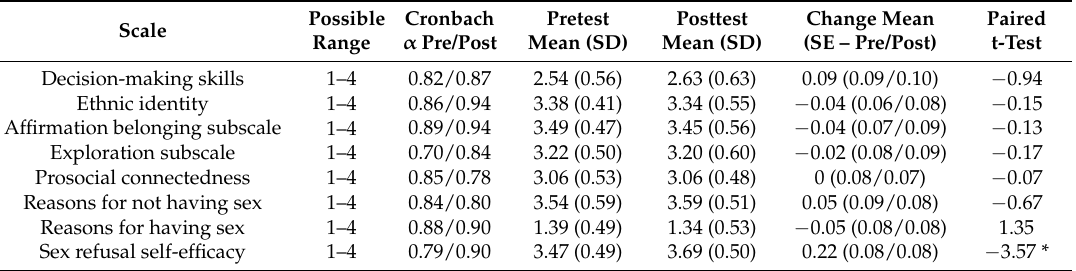
Table 2. Comparison of Pre-Test and Post-Test Scores on Scales of Interest ( n =